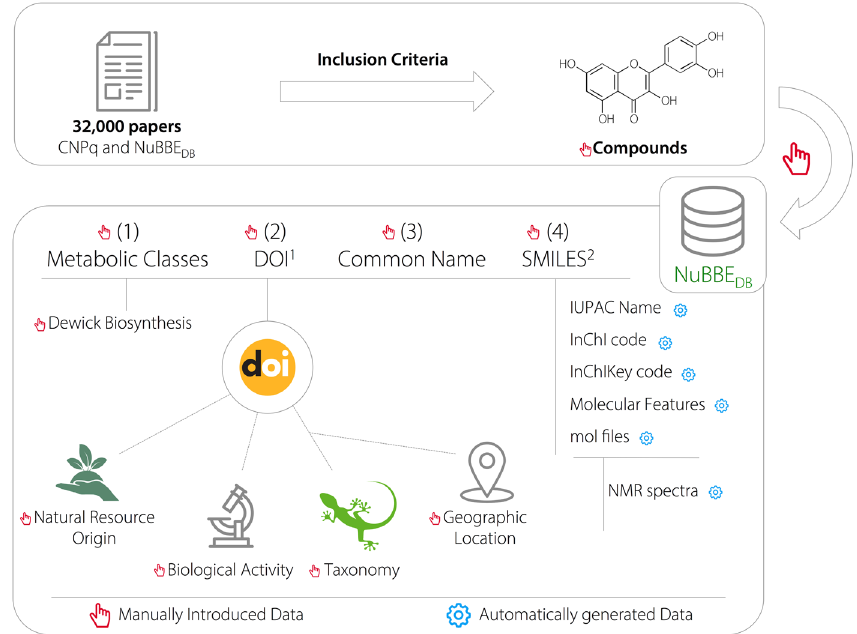
Figure 1. Schematic representation of the hierarchical process of data entry for the NuBBE DB website. This workflow is divided into two steps. First, in collaboration with governmental databases, a literature search is performed to rationalize and organize all available information about Brazilian biodiversity. Subsequently, data are analyzed, and information such as structure, biological properties, source and geographical location is manually introduced into the database. The IUPAC name, InChI codes, molecular features, MOL files and NMR spectra are automatically generated from